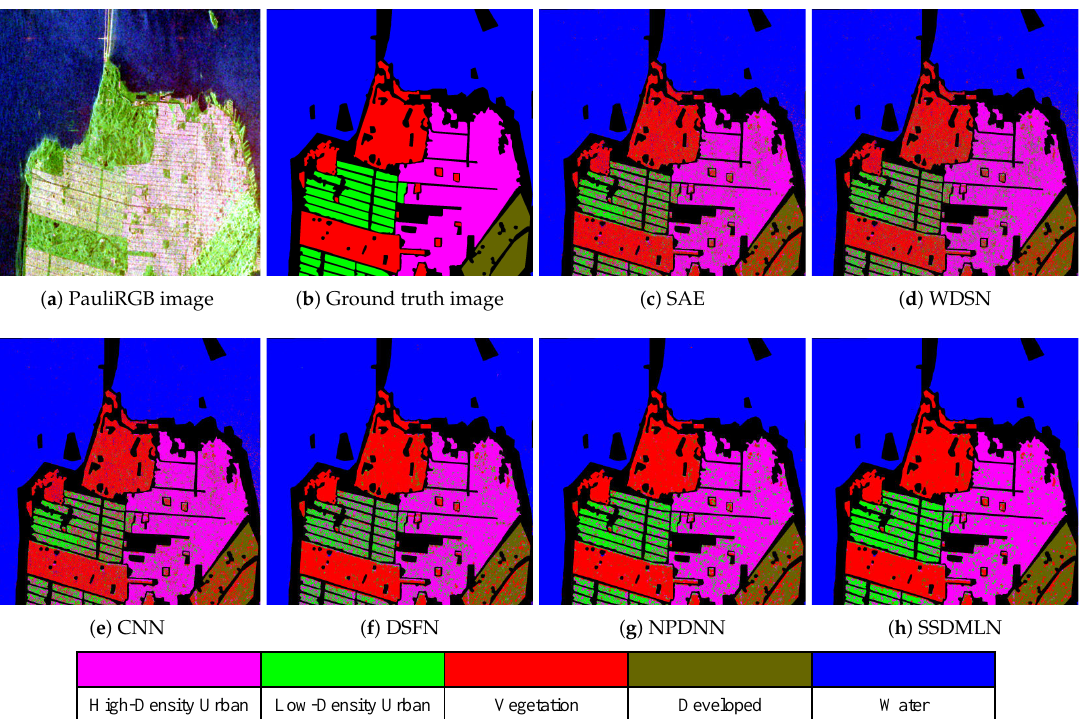
Figure 6. Comparison of classification results on the San Francisco data set using 1% labeled data. ( a ) PauliRGB image. ( b ) Ground truth. ( c ) SAE [8]. ( d ) WDSN [9]. ( e ) CNN [10]. ( f ) DSFN [16]. ( g ) NPDNN [17]. ( h ) SSDMLN (ours). Table 3. Classification results (%) on San Francisco data set with 1% labeled data.